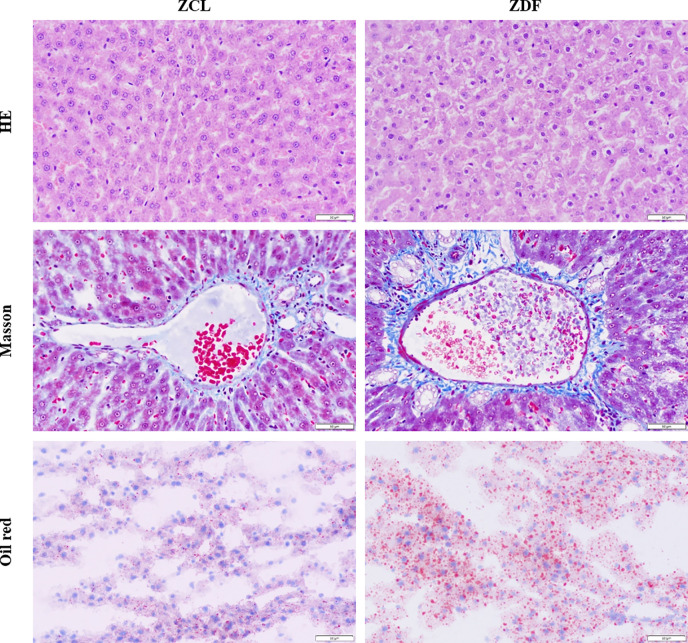
HE, Masson trichrome and Oil red staining of the liver samples from the 22-week-old Zucker diabetic fatty (ZDF) and Zucker control lean (ZCL) rats (Scale bar: 50 µm; 400x).